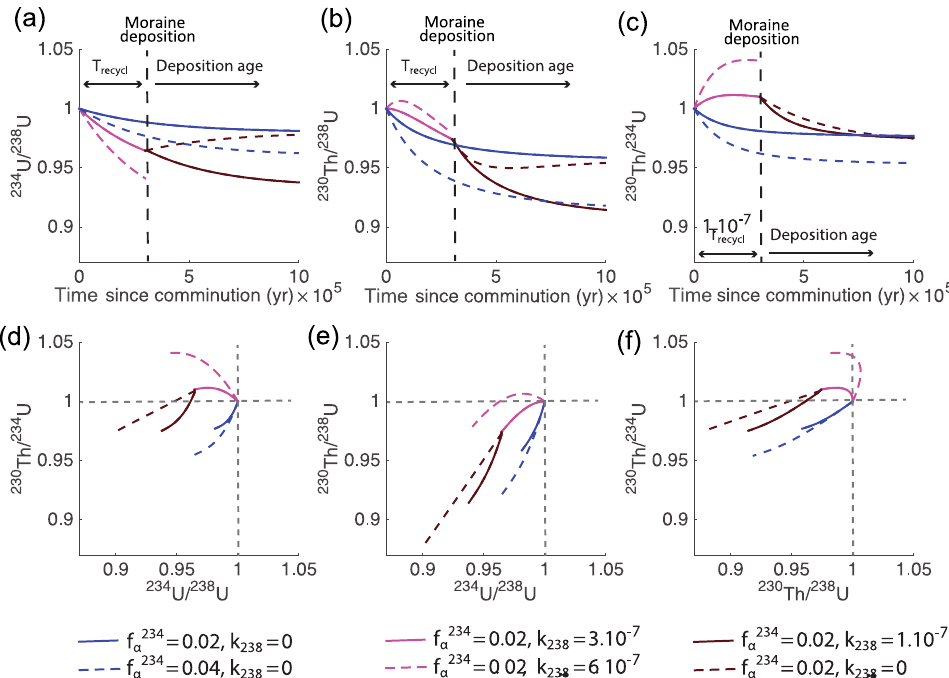
Figure 3. Solutions to Eq. 3 that we use as the theoretical framework to analyze our data for different values of f α and k 238 (we consider k 234 /k 238 = 1 . 4 and k 230 /k 238 = 0 . 5). The time evolution of 234 U / 238 U (a) , 230 Th / 238 U (b) and 230 Th / 234 U (c) activity ratios. The vertical dashed line represents an event through which the weathering intensity varies: this corresponds in our case to the time of sediment remobilization. Our 10 Be exposure ages give the time elapsed since this event (shown by the dashed vertical line), whereas the U–Th data indicate the duration of the first phase since comminution and remobilization (from the x axis origin to the dashed vertical line). ( d , e and f ) The co-evolution of the ratios in (a) , (b) and (c) , respectively. Different scenarios are plotted corresponding to different f α values and weathering intensities to illustrate potential patterns in the comminution weathering model (see legend and Sect. 2.3.1). Observing these figures helps in understanding the range of variations in the different activity ratios and the effect of each parameter ( α recoil and weathering) on these ratios before and after the remobilization of